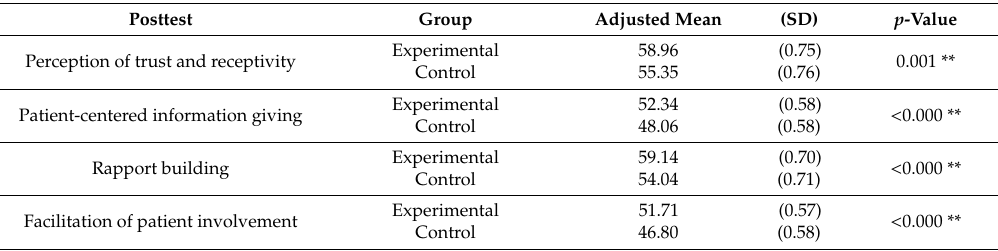
Table 6. MANCOVA and the adjusted posttest means for the P-HCS.